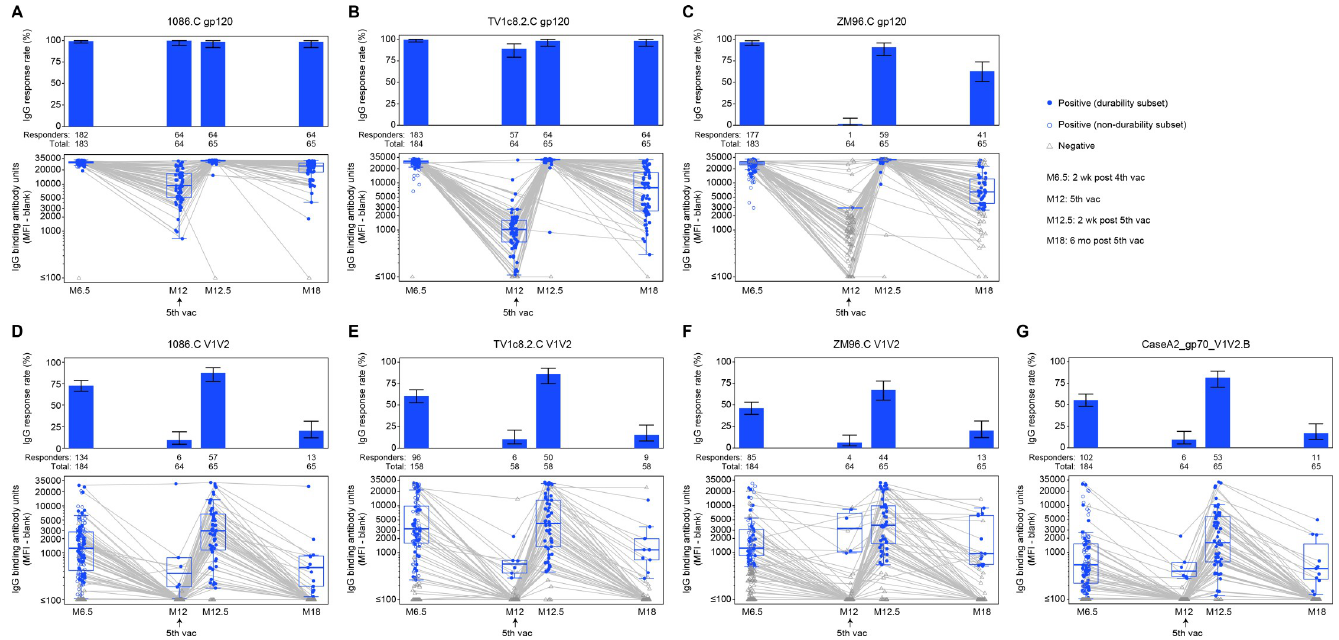
Fig 3. Summary of response rates and magnitudes of IgG binding antibodies to gp120 and V1V2 antigens among per-protocol vaccine recipients of HVTN 100. Responses to gp120 (A–C) and V1V2 antigens (D–G). Bar charts show response rates with 2-sided 95% CIs. Boxplots show magnitude as log 10 (MFI-blank) responses to individual gp120 and V1V2 antigens and are based on positive responders, shown as solid blue circles; negative responders are shown as grey triangles. Grey lines connect the response magnitude of each per-protocol vaccine recipient over time. M[number], month [number]; vac, vaccination.